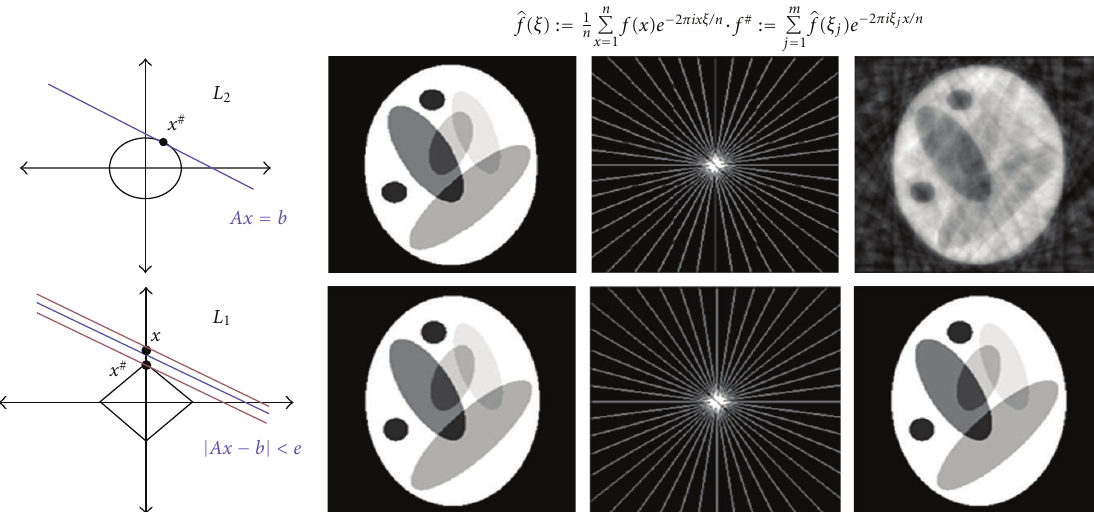
Figure 5: Compressive sensing X-ray tomography: the Logan-Shepp phantom and its least squares reconstruction after Tomography Central Lice Theorem composing 1-D Fourier-sampling projection along 22 radial lines (here 𝑚 / 𝑛 ≈ 0.05 ) into 2-D sparse spectrum which are then Fourier inverted to produce a sharp image under the 𝑙 1 norm minimization (bottom right) better than the 𝑙 2 norm (top right). 𝑌 = [Φ]𝑥 + 𝑧 , assuming that 𝑧 has norm less than some error tolerance 𝑒 . MRI Fourier Tomography Reconstruction with 5% sparse sampling using an energy LMS constraint 𝐿 2 versus magnitude convex hull constraint 𝐿 1 for 𝑀 = 22 tomography projection measurements and inverted such an underdeterminant rectangular matrix equation of degree 𝑀 ≅ 𝐾 by a linear programming, under a surrogate 𝑙 1 norm minimization of total number of nonzero pixels (irrespective to their values to select only an inhomogeneous solution without the arbitrary mixing homogenous